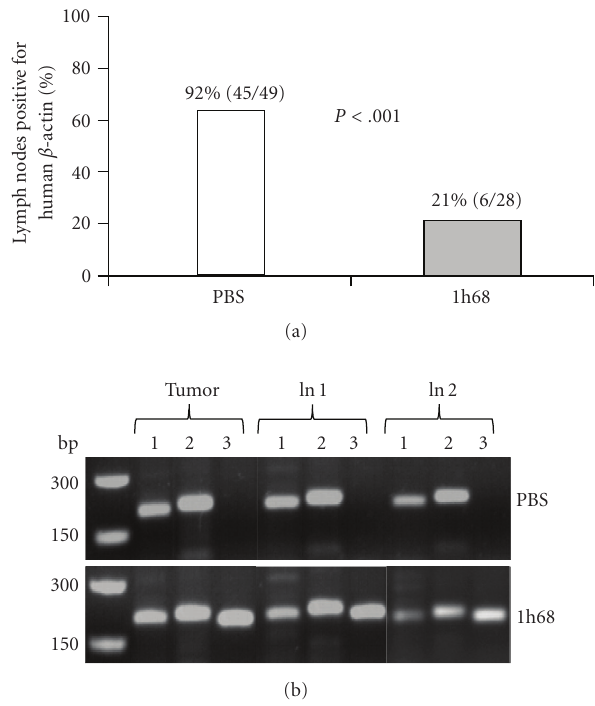
Figure 5: E ff ects of the GLV-1h68 virus on metastases formation in the regional lymph nodes. (a) Percentage of PC-3 positive regional lymph nodes in tumor-bearing mice at day 21 after PBS or virus injection. Fisher’s exact test (GraphPad Prism software, San Diego, USA) was used for statistical analysis. The value of P < . 001 was considered significant. GLV-1h68 :1h68. (b) RT-PCR analysis of tumors and regional lymph nodes of PC-3 xenograft mice injected either with PBS or with 5 × 10 6 pfu of GLV-1h68 (1h68) using primers for human beta-actin (lines 1; indicating PC-3 cancer cells, PCR-fragment 205bp), mouse beta-actin (lines 2; positive control, PCR-fragment 216 bp), and vaccinia virus (lines 3; PCR-fragment 204bp). ln: lymph node of two di ff erent